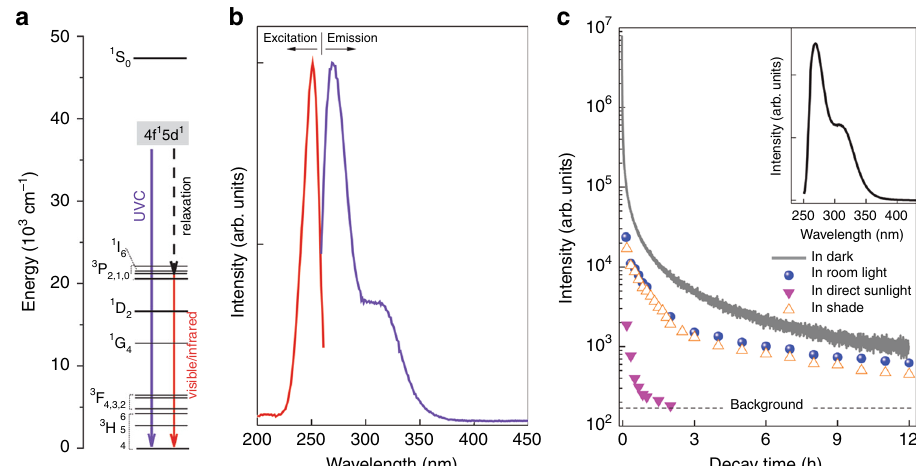
Fig. 1 Photoluminescence and persistent luminescence of Ca 2 Al 2 SiO 7 :Pr 3 + phosphor. a Energy level scheme of Pr 3 + 4 f 2 → 4 f 1 5 d 1 con fi guration and the possible optical transitions. b Normalized photoluminescence excitation and emission spectra at room temperature. The emission spectrum is acquired under 251 nm light excitation and the excitation spectrum is obtained by monitoring 268 nm emission. c Ultraviolet-C persistent luminescence decay curves monitored at 268 nm in darkness (i.e., in spectro fl uorometer sample chamber), direct sunlight, indirect sunlight (i.e., the shade of a building), and room light. The samples were pre-irradiated by a 254 nm lamp for 2 min. For in darkness, the decay curve was recorded continuously for 12 h. For in direct sunlight, indirect sunlight, and room light, the samples were taken back to the spectro fl uorometer to measure the remaining persistent luminescence intensity at every 10 min in the fi rst 1 h and at variable time interval (10 min, 30 min, or 1 h) in the rest of decay. Inset shows the persistent luminescence emission spectrum acquired at 1 h decay in darkness. Source data for b , c are provided as a Source Data fi